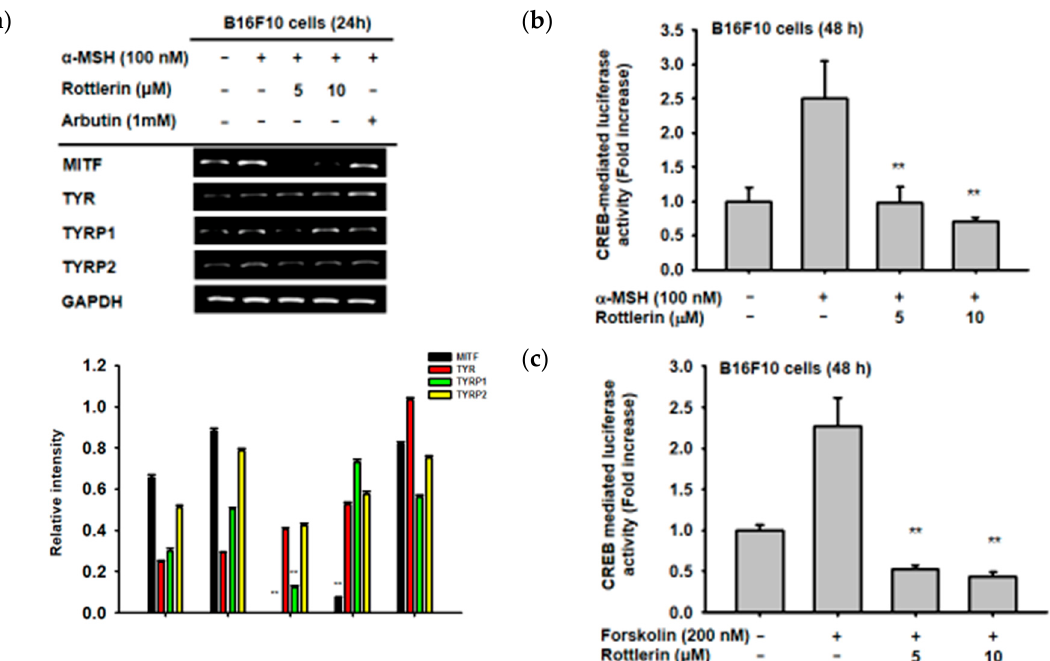
Figure 3. E ff ect of rottlerin on genes involved in melanogenesis and CREB (cAMP response element binding) transcription factor. ( a ) Semi-quantitative PCR was carried out to measure mRNA expression of MITF, TYR (tyrosinase), TYRP1 (tyrosinase related protein 1), and TYRP2 in B16-F10 cells (10 5 cells / mL) stimulated by α -MSH in the presence or absence of 5 and 10 µ M of rottlerin. ( b ) and ( c ) B16-F10 cells (10 5 cells / mL) were transfected with CREB-luciferase (CREB-Luc) and beta-galactosidase ( β -gal, 0.8 µ g) for 48 h, activated with α -MSH 24 h after CREB-Luc transfection, and ( c ) treated with forskolin (200 nM) with or without 5 and 10 µ M of rottlerin. All data ( b , c ) are expressed as the mean ± SD of three replicates. ** p < 0.01 compared to control